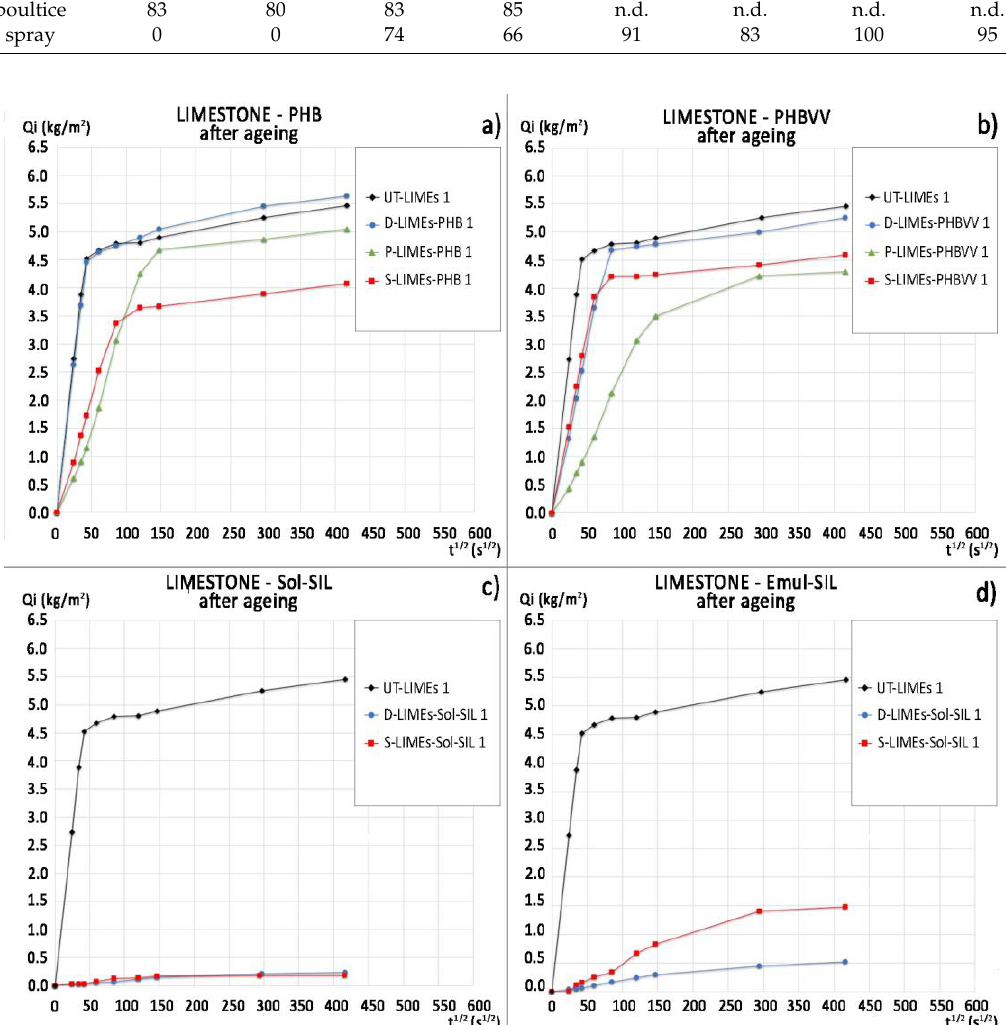
Figure 12. Capillary water absorption curves of limestone after artificial ageing referred to: ( a ) samples treated with PHB-based formulation; ( b ) samples treated with PHBVV-based formulation; ( c ) samples treated with Sol-SIL; ( d ) samples treated with Emul-SIL.